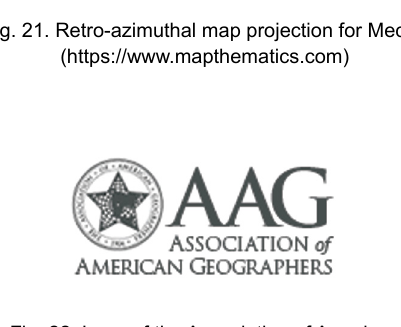
Fig. 22. Logo of the Association of American Geographers